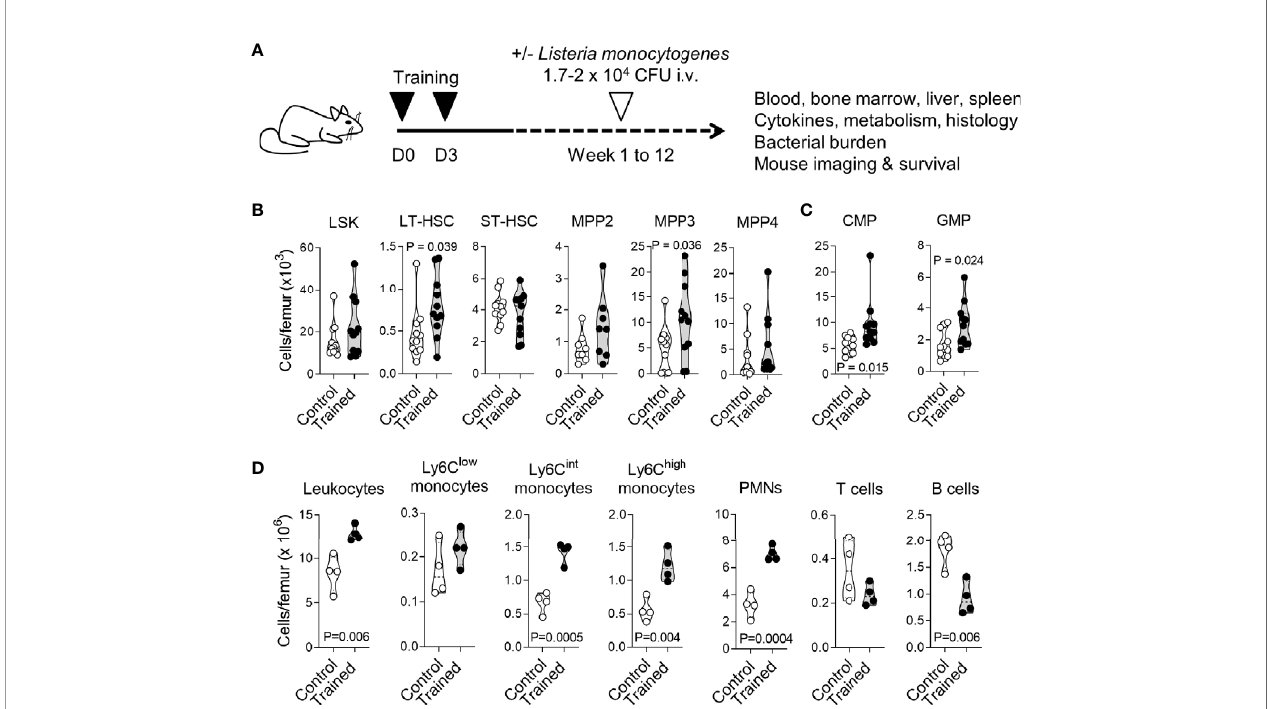
FIGURE 1 | Training for 9 weeks promotes myelopoiesis. (A) Experimental model to study trained immunity. (B, C) Bone marrow cells were collected from control mice ( n = 11) and mice trained 9 weeks ( n = 4) and 12 weeks ( n = 7) before analysis. Cell populations were analyzed by fl ow cytometry for hematopoietic progenitors (LSK), long-term hematopoietic stem cells (LT-HSC), short-term HSC (ST-HSC), multipotent progenitors (MPP) 2, MPP3 and MPP4 (B) , common myeloid progenitors (CMP) and granulocyte-monocyte progenitors (GMP) (C) . (D) CD45 + leukocytes, Ly6C low , Ly6C lint and Ly6C high monocytes (CD11b + Ly6G - ), PMNs (Ly6G + ), T cells (CD3 + ) and B cells (B220 + ) in the bone marrow from control mice ( n = 4) and mice trained for 9 weeks ( n = 4). Each dot of the violin plots represents data from one individual mouse, and the dashed horizontal lines the quartiles. P values are given in the